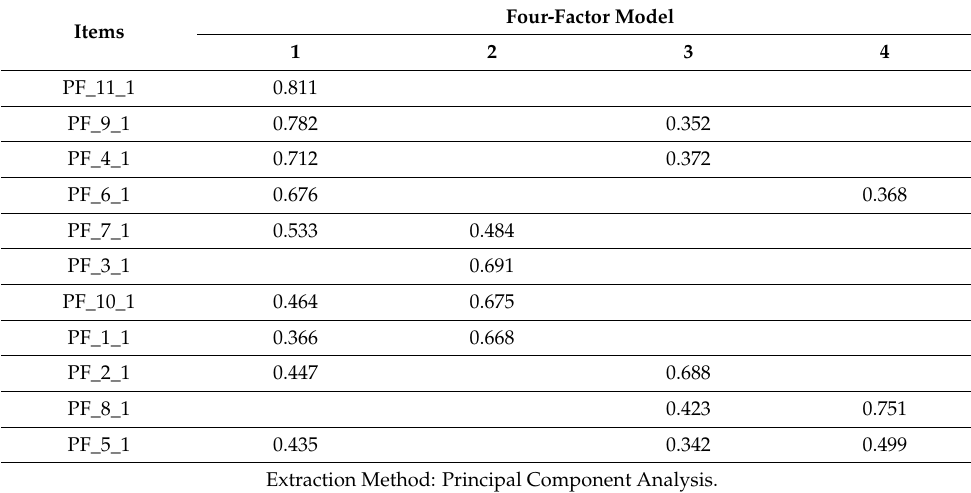
Table 5. Four-factor model with factor loading under 11 items.